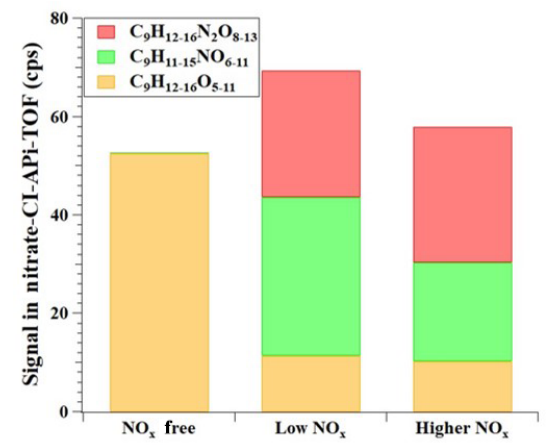
Figure 6. Comparison of C 9 products detected by the nitrate CI- APi-TOF with zero, one or two nitrogen atoms formed from 1,2,4- TMB oxidation with different NO x